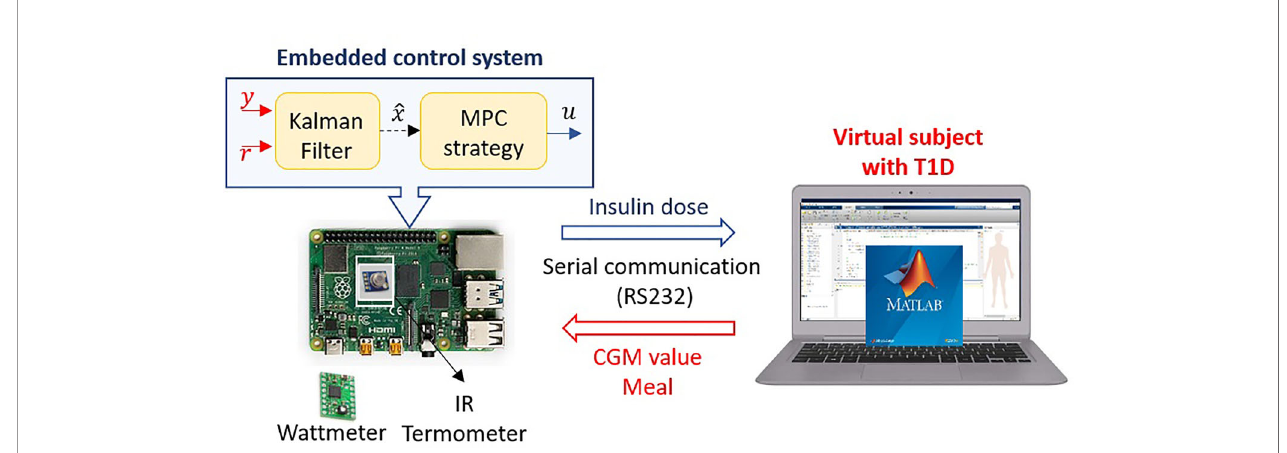
FIGURE 1 | Hardware-in-the-loop implementation to emulate the AP system. The images used in this graphic are by unknown author under a CC BY-SA license.